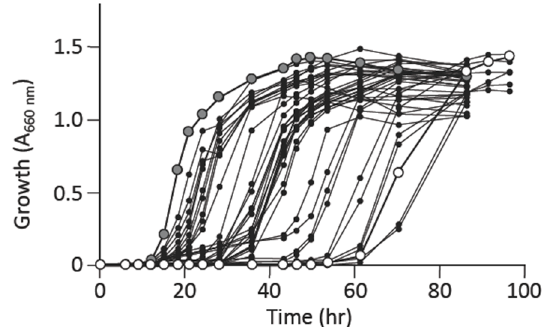
Figure 2. Growth of distinct L-alanine prototrophic suppressors that appeared on minimal agar medium. Here, 32 independent clones were grown in a minimal liquid medium without L-alanine supplementation. Symbols: large grey circles, W3110; large open circles, HYE032; small black circles, independent L-alanine suppressors. The figure shows a representative result from >2 experiments.